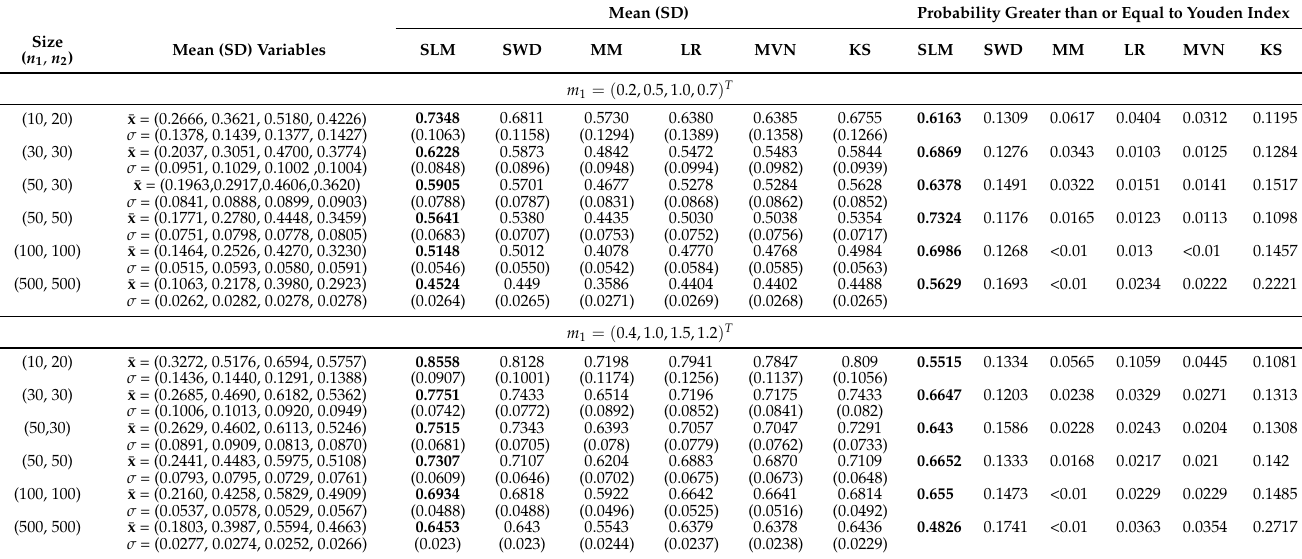
Table 2. Normal distributions: Different means. Low correlation ( Σ 1 = Σ 2 = 0.7 · I + 0.3 · J